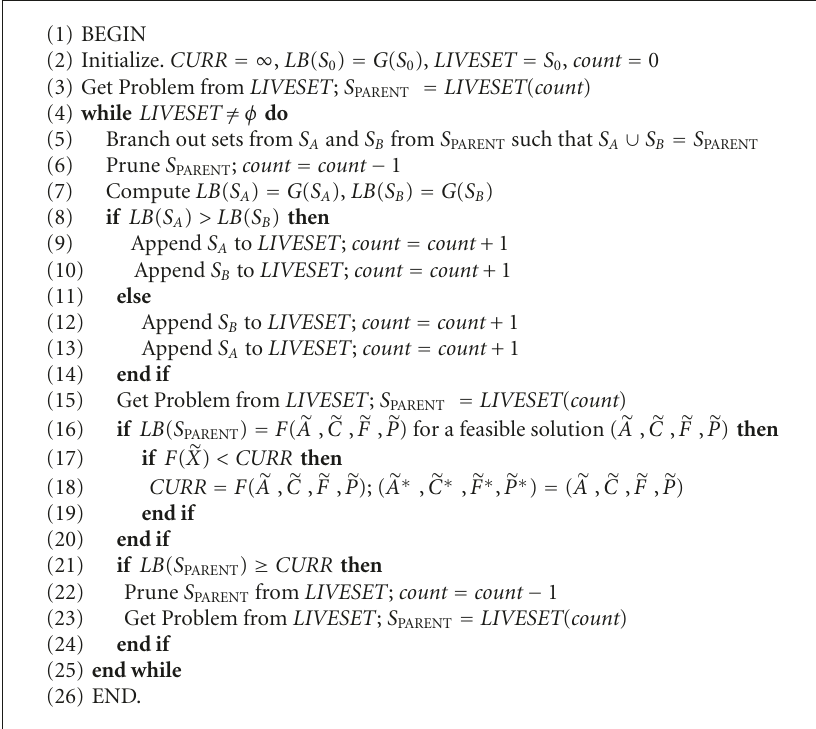
Algorithm 1: Branch and bound